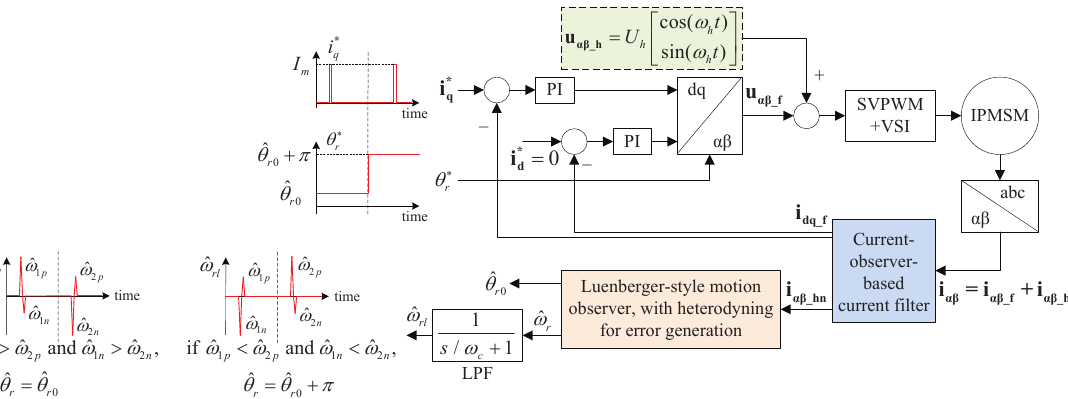
Figure 8. Rotor polarity detection based on torque